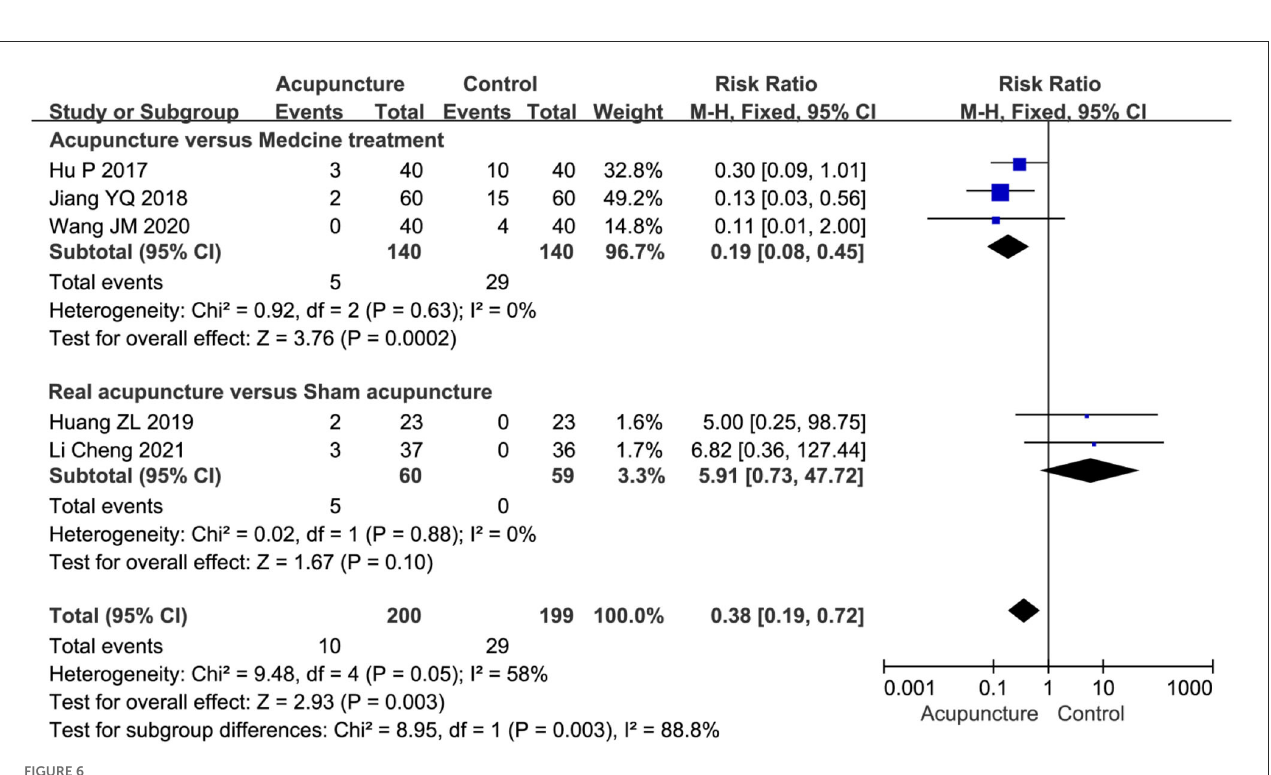
FIGURE6 A Forest plot for adverse